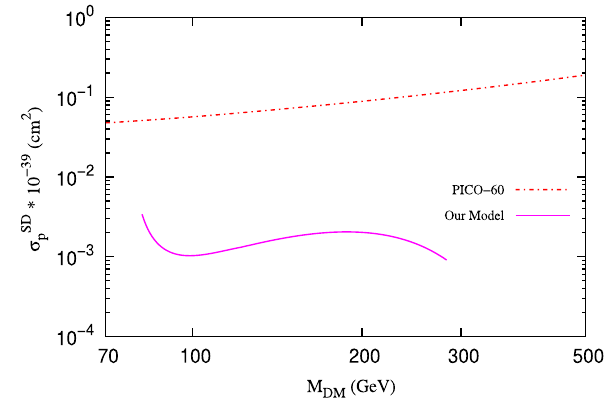
curves show the variation of (cid:9) σv (cid:10) with DM masses for